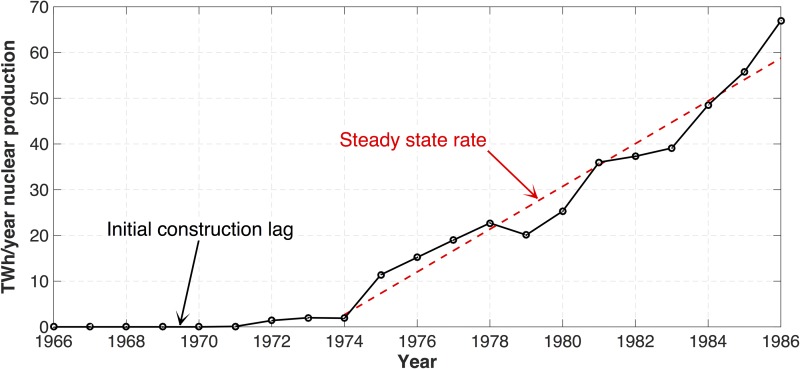
Swedish nuclear electricity production 1966–1986 [14].